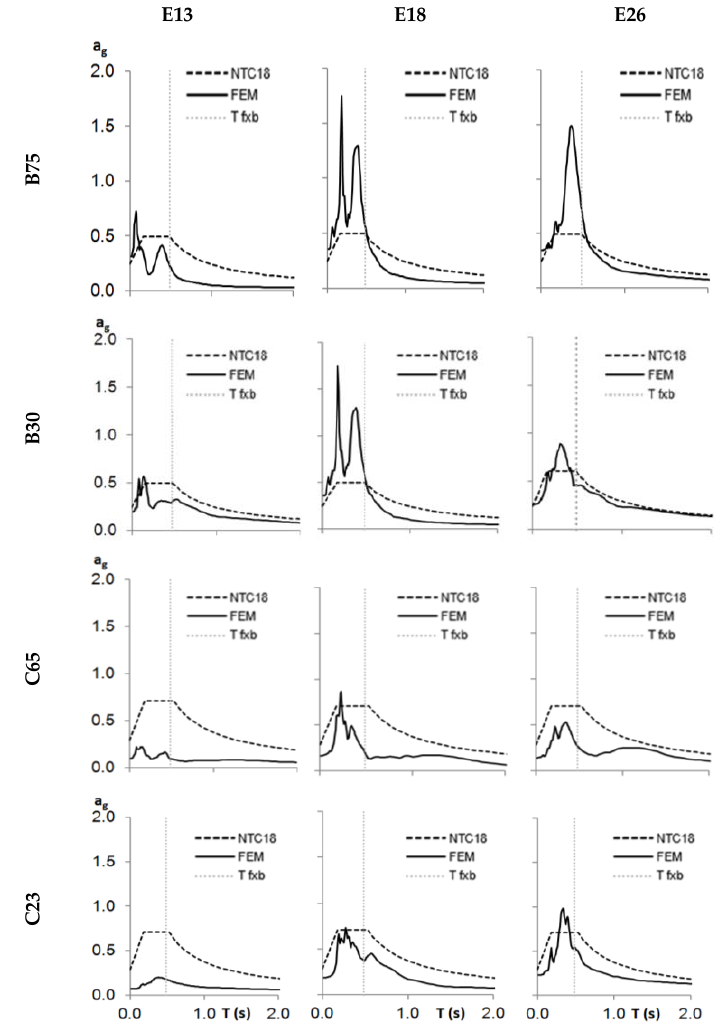
Figure 11. Comparison between response spectra at the base of the structure achieved by numerical analyses and provided by [24].